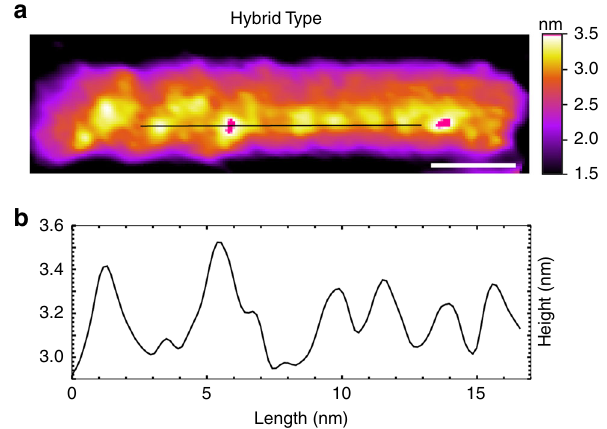
Fig. 3 Hybrid-Type G-wire. a AFM image and b height pro fi le of a Hybrid- Type G-wire demonstrating distinct regions of different periodicities. The length scale (white bar) is 5